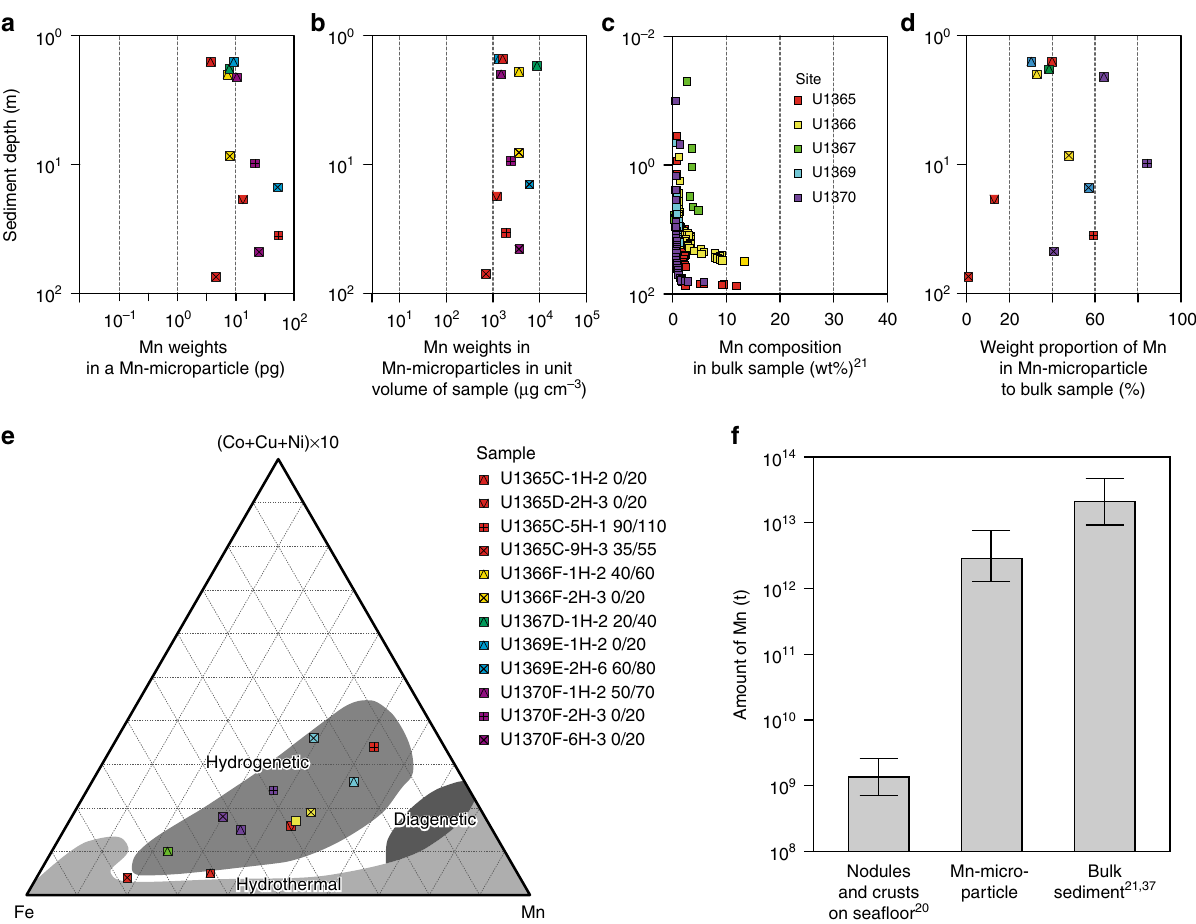
Fig. 4 Origins and budget of manganese in Mn-microparticles in oxic pelagic sediments. a – d Depth pro fi les of mass and proportion of manganese in Mn- microparticles in sediment samples: a average mass of major elements in a Mn-microparticle; b average mass of manganese in Mn-microparticles in a unit volume of sample; c major-element composition of the bulk sample 21 ; and d proportion of Mn-microparticle manganese mass to bulk sample mass. e Fe – Mn – (Co + Cu + Ni) × 10 ternary diagram 22 for the Mn-microparticles. f Comparison of the manganese budgets estimated for Mn-nodules and crusts on the sea fl oor 20 , Mn-microparticles in oxic pelagic clay, and a bulk sample of oxic pelagic clay 21 . Whiskers represent maximum and minimum